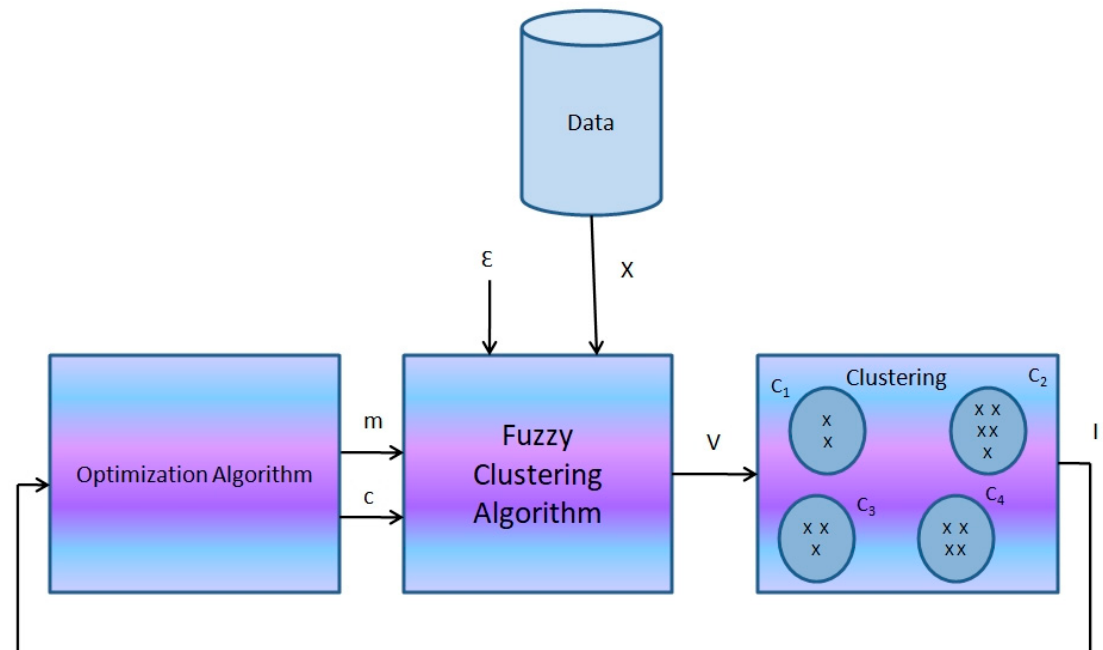
Figure 1. Architecture of bio-inspired optimization fuzzy clustering approaches.